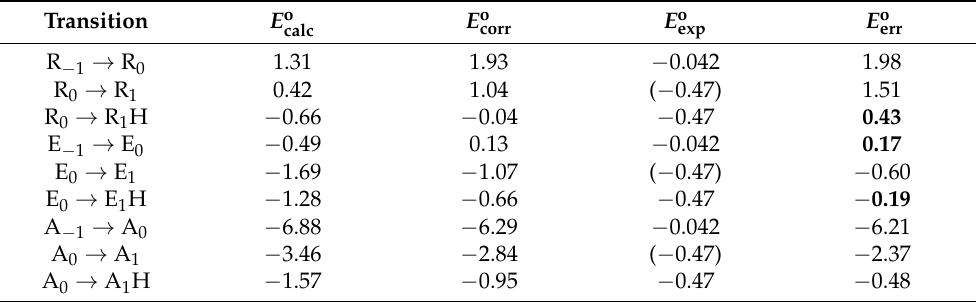
Table 4. Redox potentials for various redox couples of the FeMo cluster in V. E o + 0.62 V (the MSE in our previous study [41]), E o potentials, E o corr = E o calc potentials (for the E 0 /E 1 couple, we used − 0.47 V, which is in the middle of the range of reported values) [5,24,25,27–29] and E o err is the error for the various calculations. Results with E o err < 0.44 V are marked in bold face. Transition E o calc